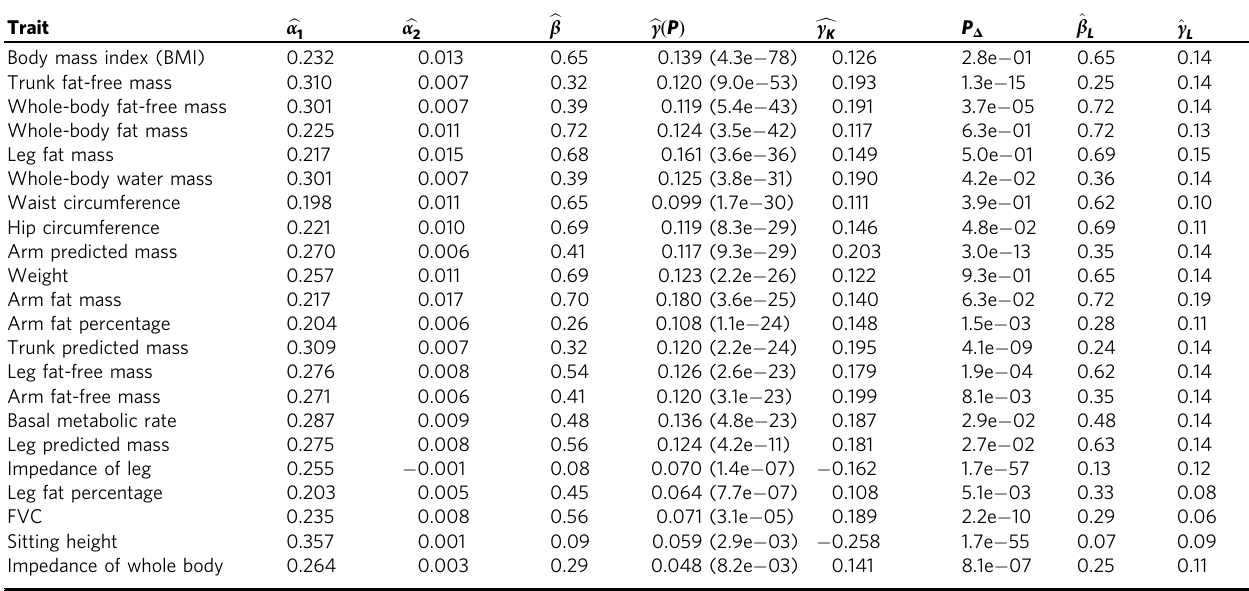
Table 1 Estimated contribution of GRS×E effects for 22 traits in the UK biobank. Trait